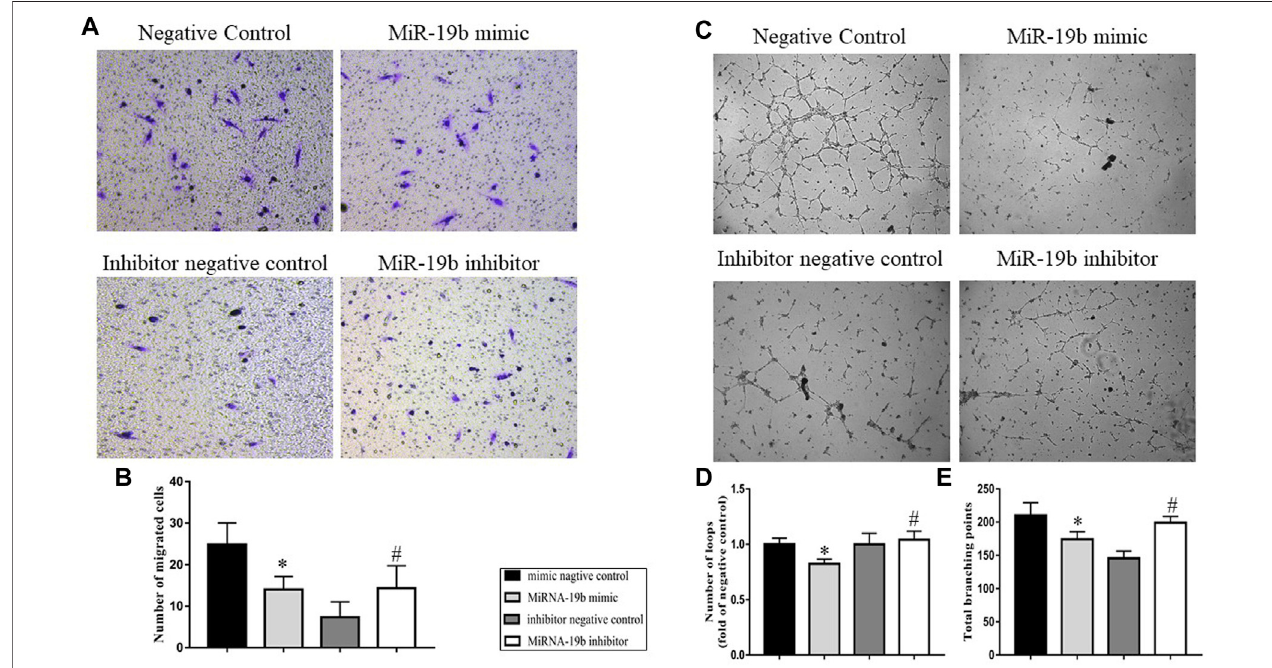
FIGURE 6 | Effects of miR-19b on LEC migration and lymphangiogenesis. LECs were respectively transfected with miR-19b mimic (miR-19b mimic group) or a negative control fragment (negative control group), as well as miR-19b inhibitor (miR-19b inhibitor group) or a corresponding negative control (inhibitor negative control group). (A) Cell migration was assessed by Transwell migration assay and (B) quanti fi ed by measuring the number of migrated LECs; n = 3. (C) In vitro lymphangiogenesiswasanalyzedbytubeformationassayandquanti fi edbymeasuringthetotalnumberof (D) branchingpointsand (E) loops; n =3.Magni fi cation, ×100. * p < 0.05 compared with negative control group, # p < 0.05 compared with the negative control